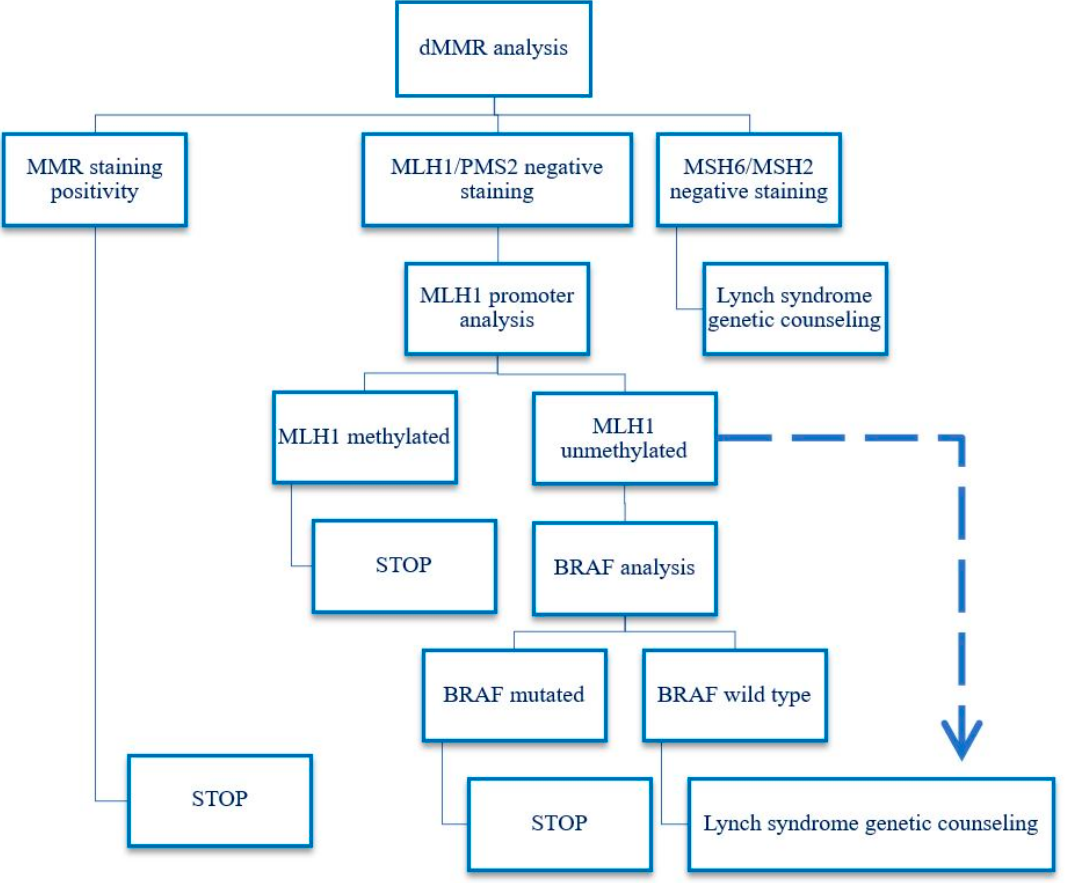
Figure 5. Cost-effective algorithm for MLH1 promoter methylation and BRAF analyses in dMMR/MSI-H CRC at the University of Bologna medical center. The dashed arrow indicates the possible algorithm if MLH1 promoter methylation analysis is used as a stand-alone test for Lynch syndrome risk screening.